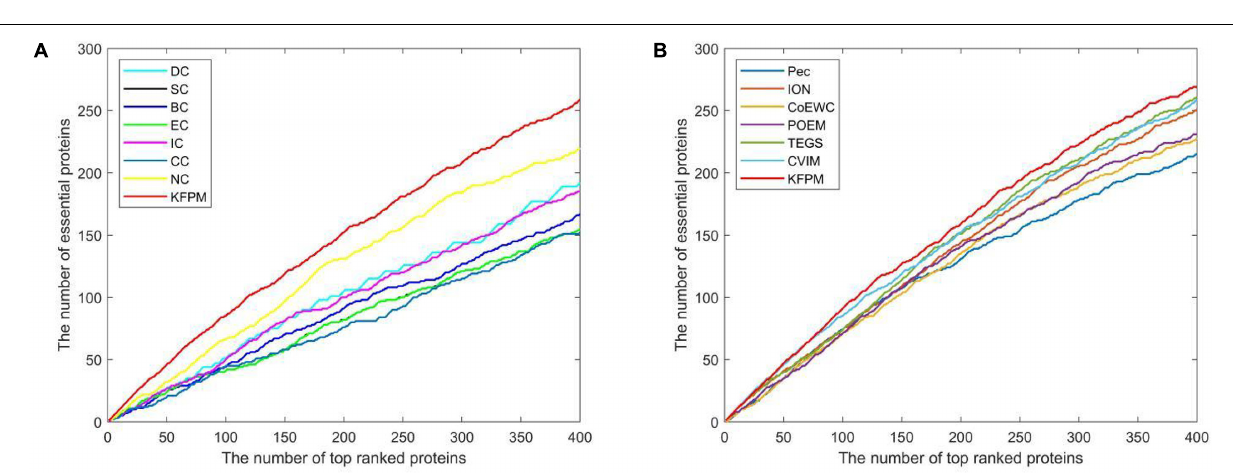
FIGURE 5 | Performance comparison between KFPM and 13 state-of-the-art methods based on the method of Jackknife under the Krogan database. (A) Comparison between KFPM and DC, SC, BC, EC, IC, CC, NC. (B) Comparison between KFPM and Pec, CoEWC, POEM, ION, TEGS,